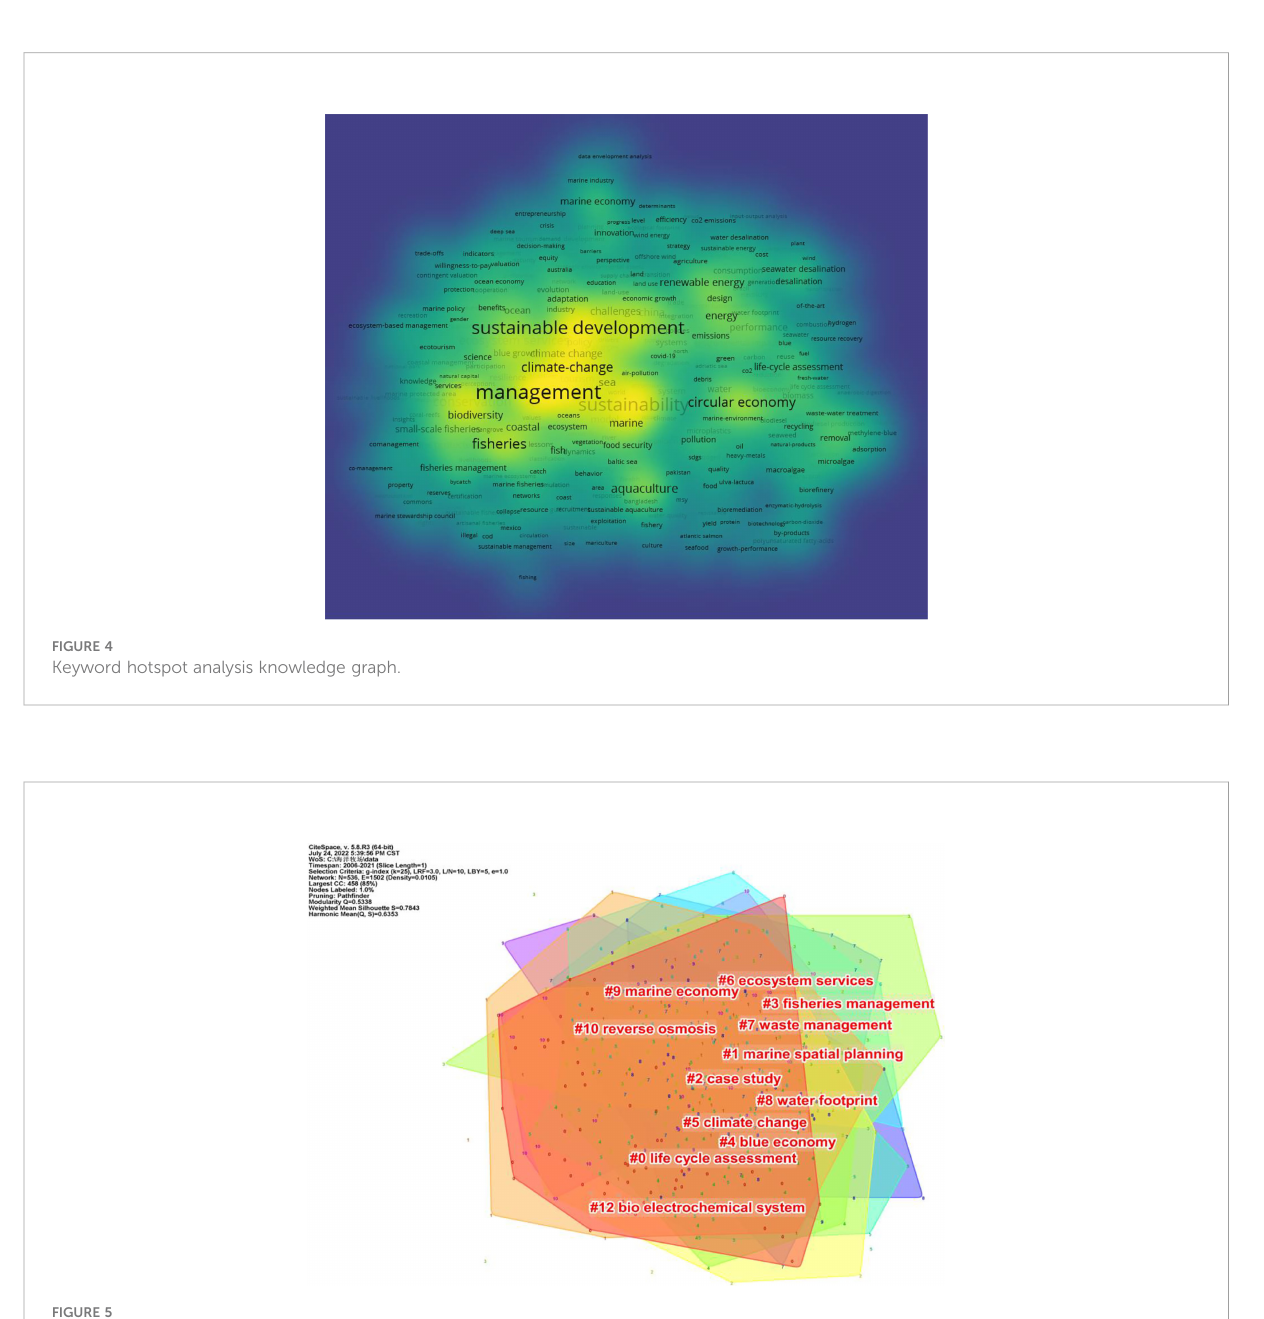
FIGURE 5 Knowledge graph of keyword